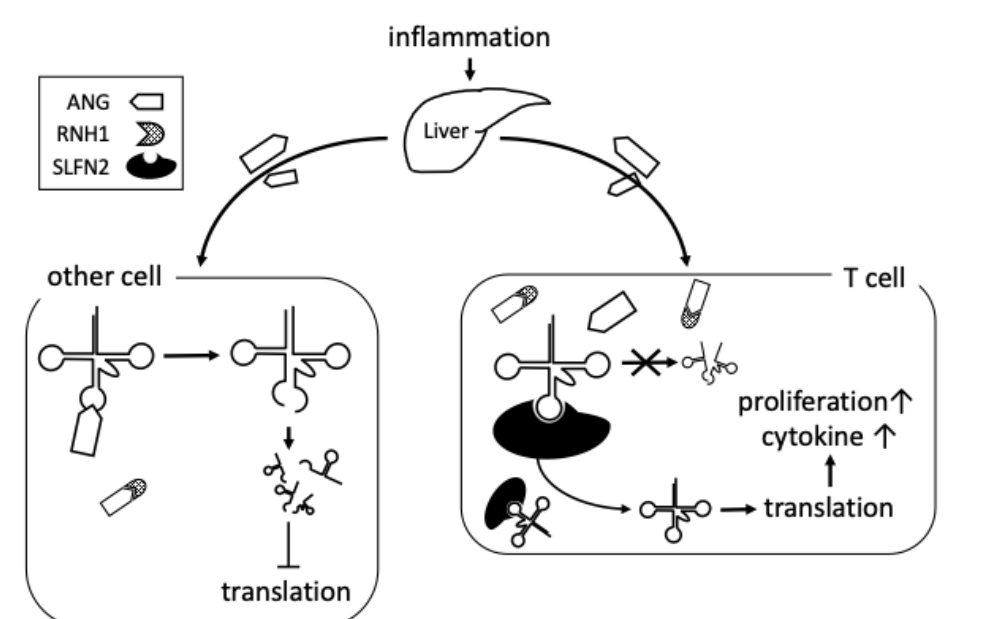
Figure 2. Control of tiRNA in T cells in an inflammatory environment. Inflammation promotes ANG production in the liver. ANG binds to receptors on other cells and is taken up by endocytosis. If incorporated ANG is not inhibited by RNH1, it cleaves mature tRNAs to produce tiRNAs and suppresses global translation. In T cells, SLFN2 protects tRNAs from ROS-mediated cleavage by ANG. This inhibits the production of tiRNA and allows translation for sustained activation of T cells.